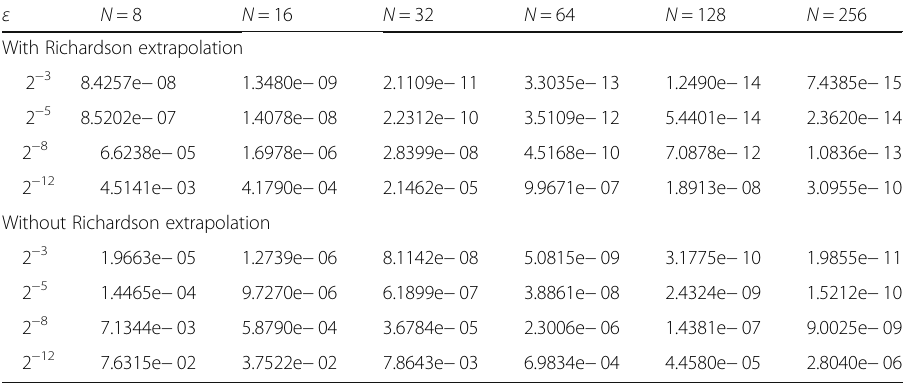
Without Richardson extrapolation 2 − 3